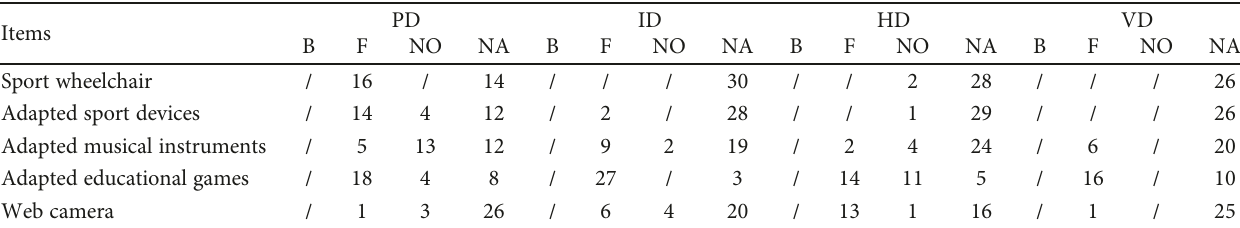
Table 6: Facilitators and barriers of AT for recreation.